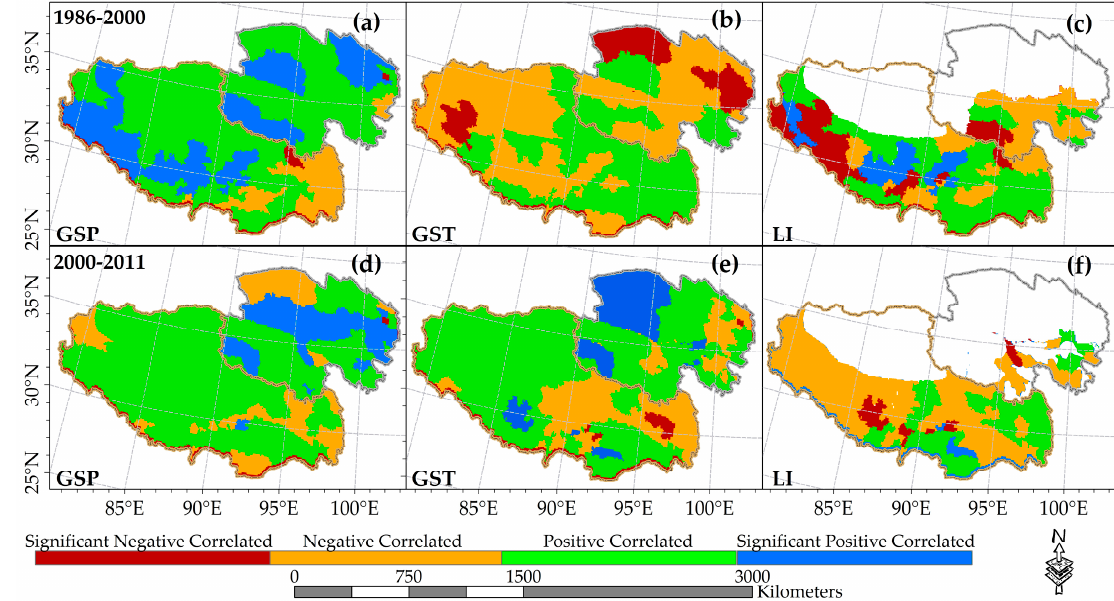
Figure 6. The correlation coefficients for: ( a ) The growing season precipitation (GSP) and the growing season NDVI (GSNDVI) for 1986–2000; ( b ) The growing season temperature (GST) and GSNDVI for 1986–2000; ( c ) Livestock grazing intensity (LI) and GSNDVI for 1986–2000; ( d ) GSP and GSNDVI for 2000–2011; ( e ) GST and GSNDVI for 2000–2011; and ( f ) LI and GSNDVI for 2000–2011.